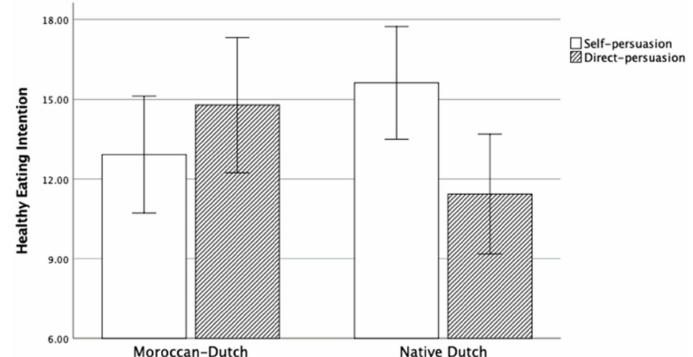
Figure 1. The interaction between persuasion and cultural background in Study